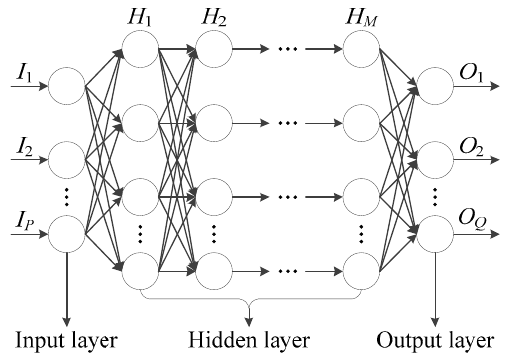
Figure 9. Structure of BP neural network.